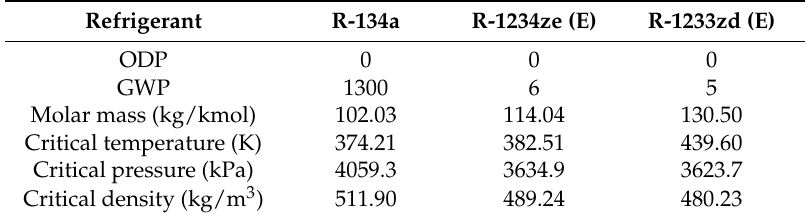
Figure 3. Comparison of thermodynamic diagrams for R-134a, R-1234ze (E), and R-1233zd (E). ( a ) Pressure-enthalpy diagram and ( b ) pressure-temperature diagram. Table 2. Environmental impact and thermodynamic properties of refrigerants.